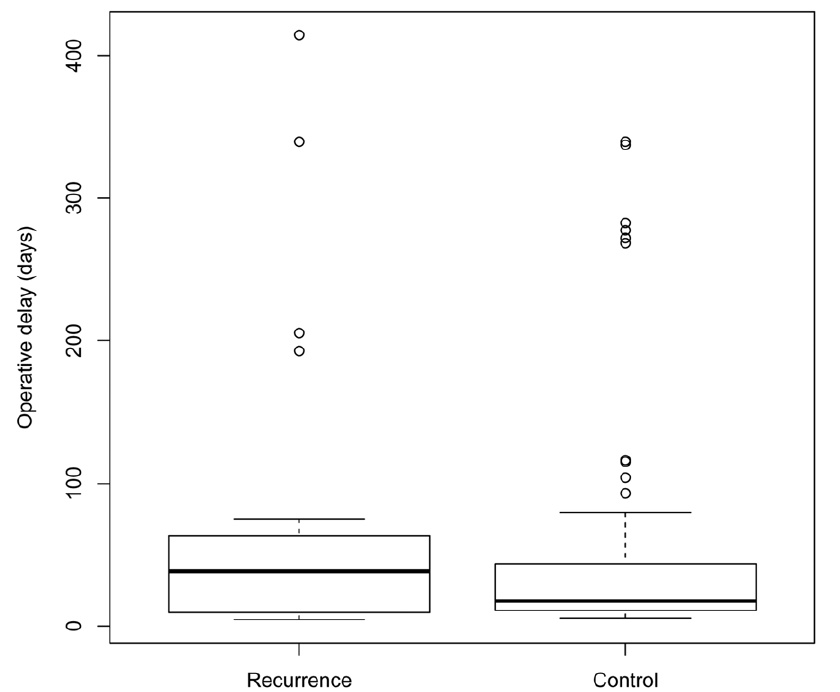
Figure 3. Operative delay for first HO excision in the case sample (‘recurrence’’) and in the control sample. The upper and lower hinges indicate the 25 th and 75 th percentiles, the line in the box indicates the median. doi:10.1371/journal.pone.0023129.g003 Comparability between the two groups: TBI versus SCI There was a significant difference between the two groups for sex (p , 0.01, no women in the SCI sub group), age at first surgery